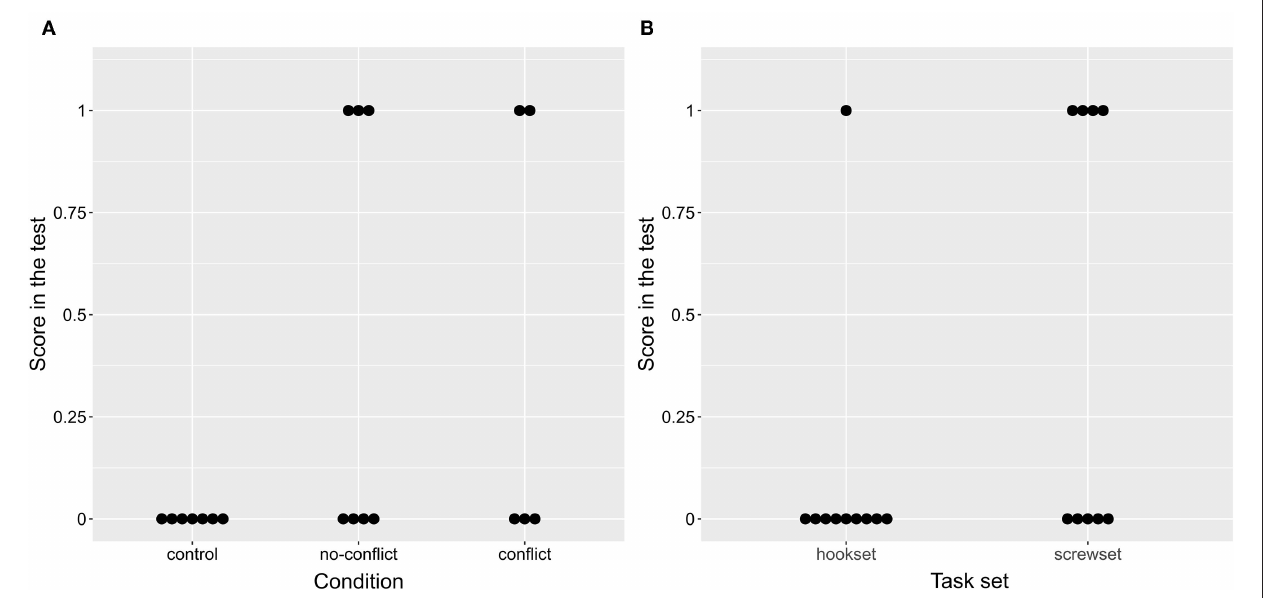
FIGURE 3 | A plot of the effect of condition (A) and task set (B) on the score in the test. Note that (B) includes results of all three conditions.